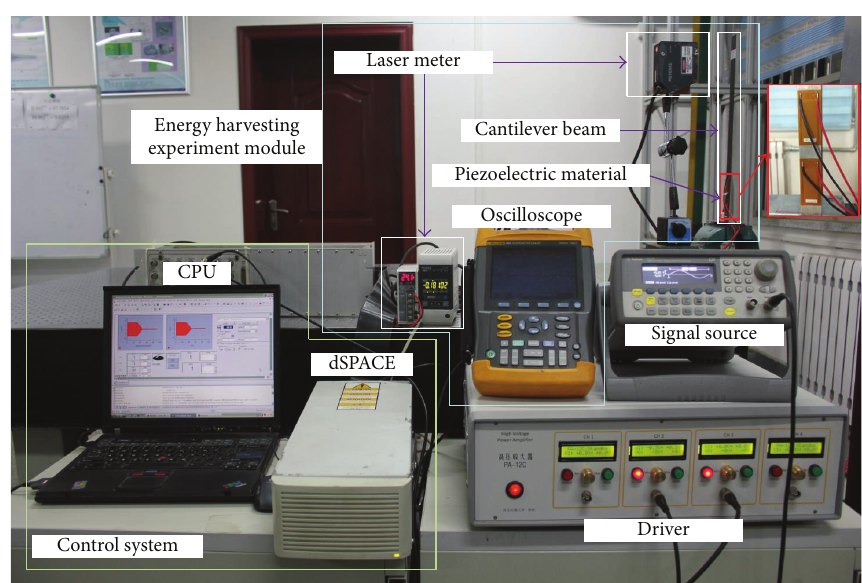
Figure 4: Outlook of active control system with